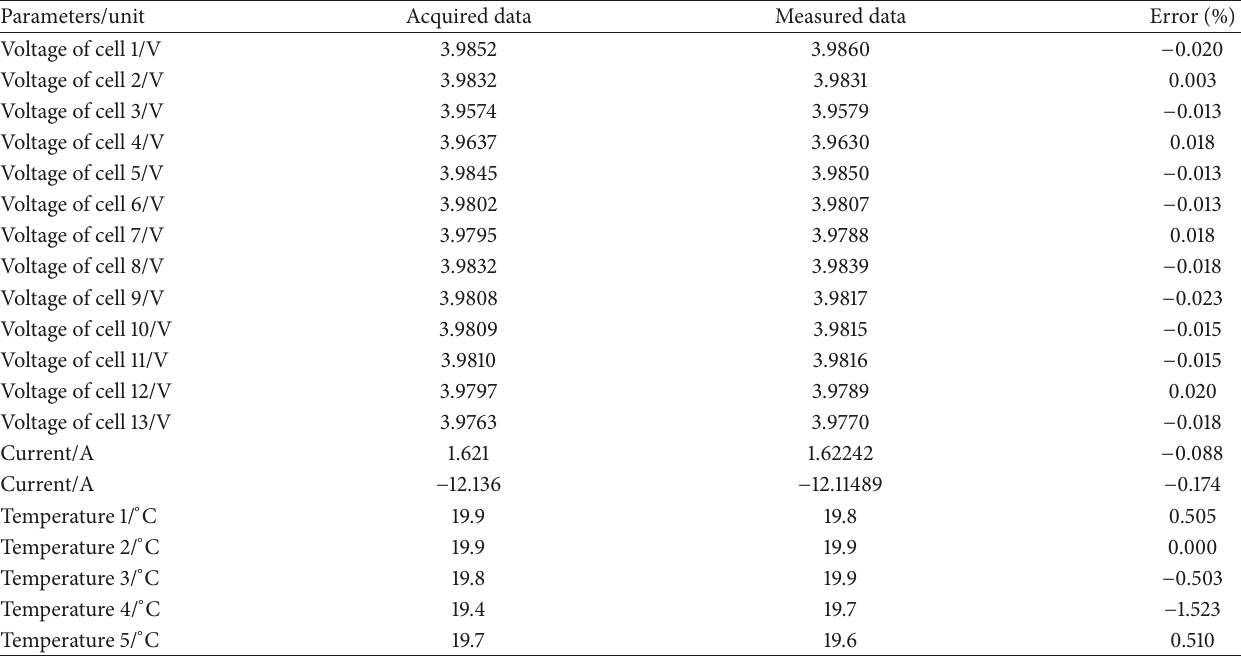
Table 1: Comparison of acquisition value with measured value.